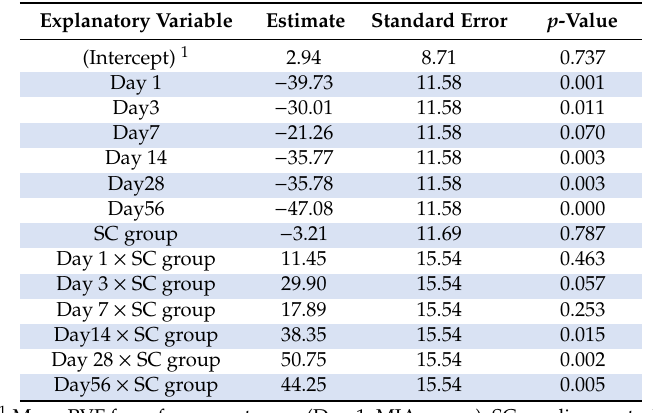
Table 5. Estimates and standard errors for intercept and di ff erences with reference category Peak Vertical Force (PVF) for each explanatory variable in the final model.